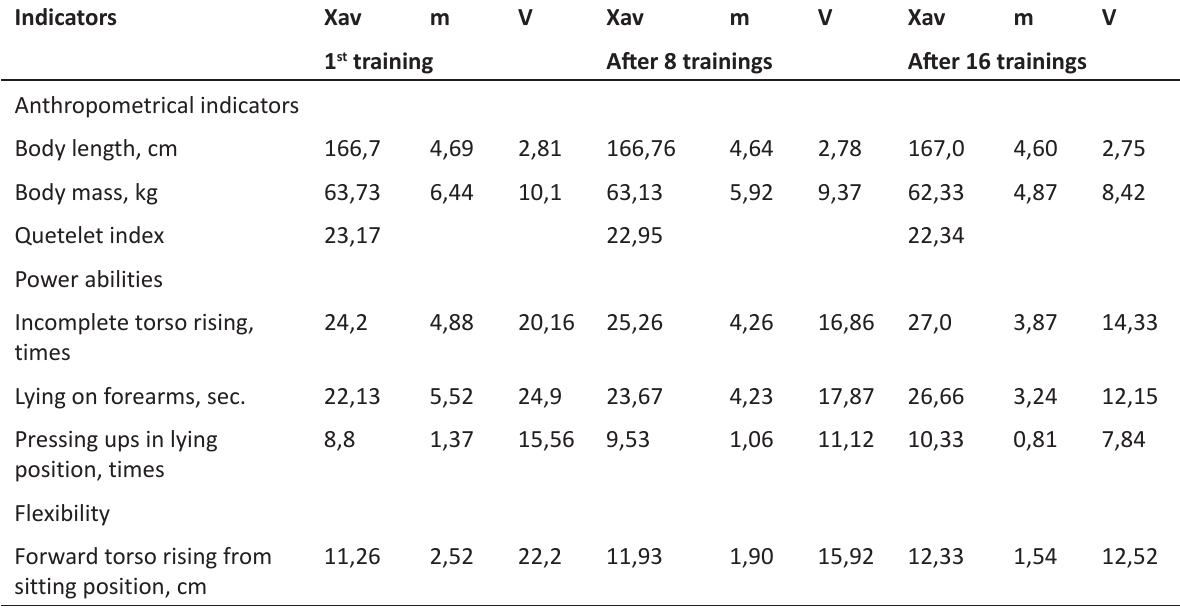
Table 1. Weight-height indicators of girl students and results of strength and flexibility testing Indicators Xav 1 st training After 8 trainings After 16 trainings Anthropometrical